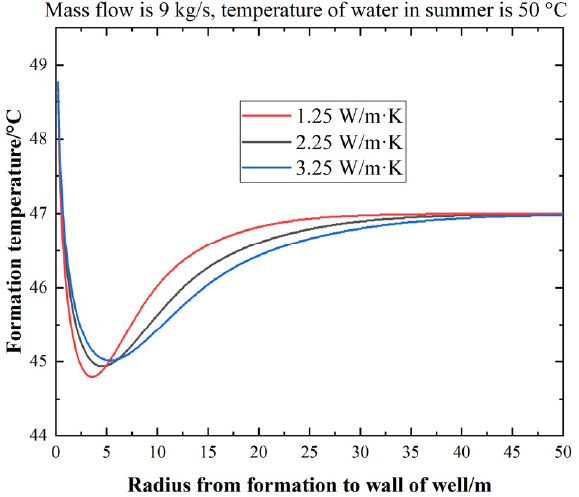
Figure 16. Formation temperature at 500 m under different thermal conductivity of formation.